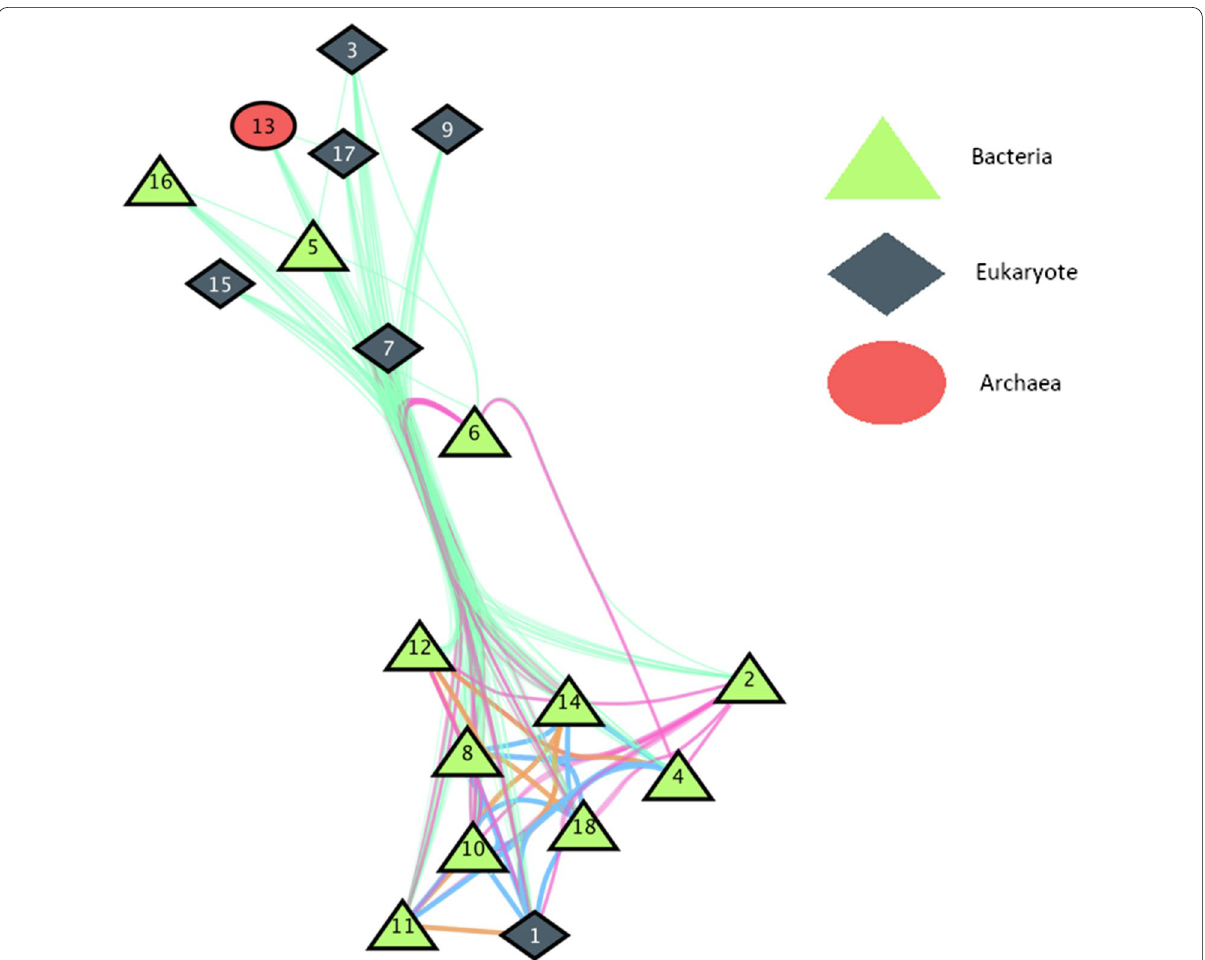
Fig. 6 Dairy cattle ruminal ARG‑sharing network. Nodes represent the taxonomic rank codified as shown in Table 2. The colour of the lines represents the strength of the relationship being 1, in light green, the weaker; 2 in pink and 3 in orange the medium, and 4 in blue the stronger. Two phyla or kingdom are connected if they share ARGs in all the farms analysed, having no coincidence in only one of them would discard the